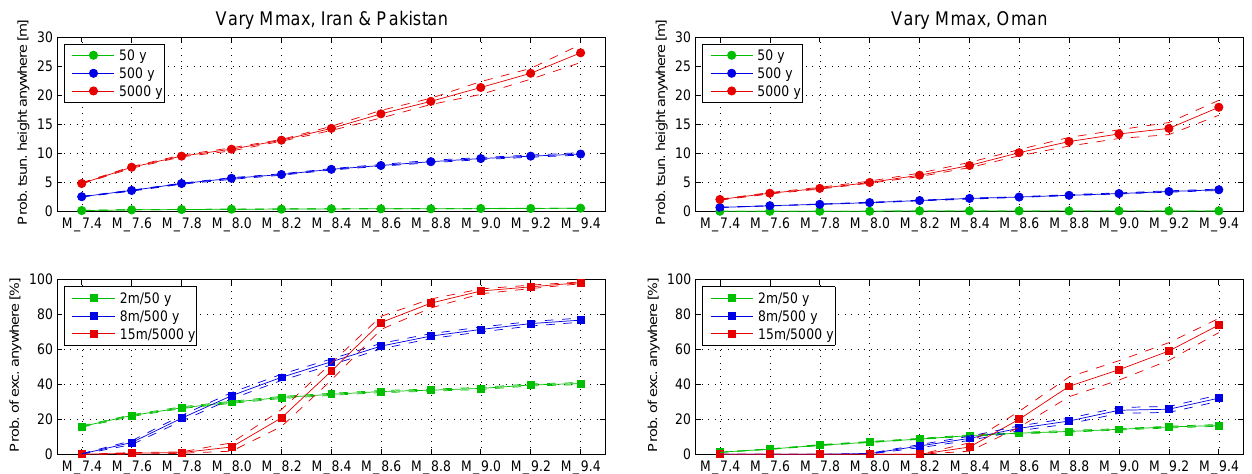
Figure 5. Influence of maximum magnitude assumption on tsunami hazard. Left: Iran and Pakistan. Right: Oman. Upper: probabilistic tsunami height (PTH). Lower: probability of exceedance (POE).